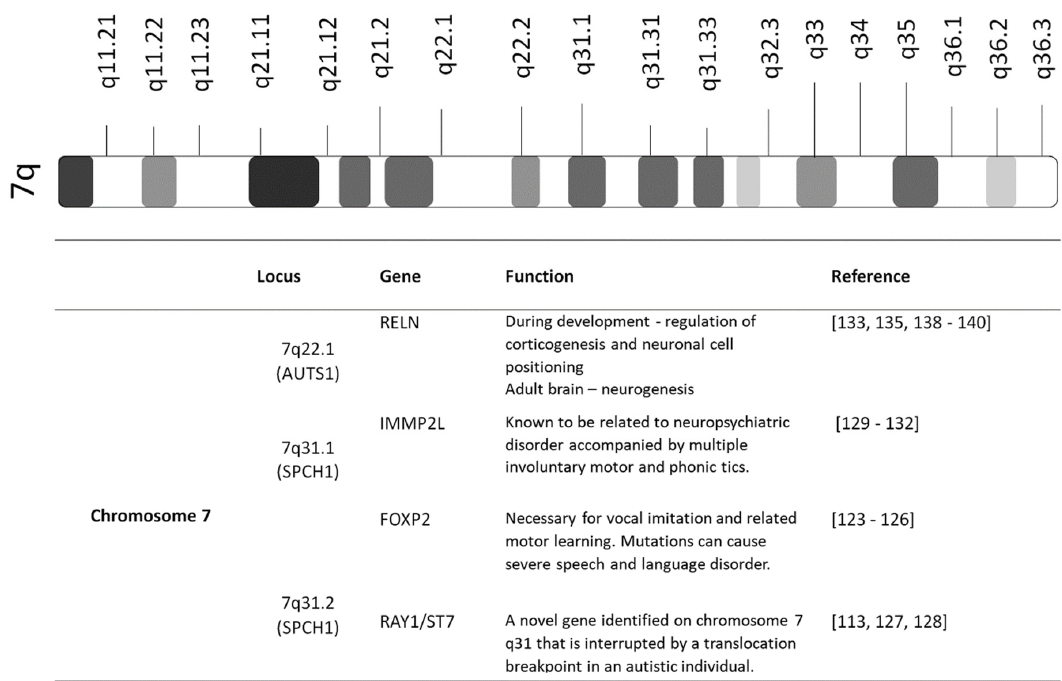
Figure 2. Loci on chromosome 7 responsible for autism spectrum disorder (ASD). Chromosome 7 contains more ASD-related regions than other chromosomes. Genome-wide association studies found SPCH1 and AUTS1 (autism susceptibility locus), which encompass RELN , IMMP2L , FOXP2 , and RAY1 / ST7 , to be the specific loci responsible for the defect in speech and language development in ASD patients.